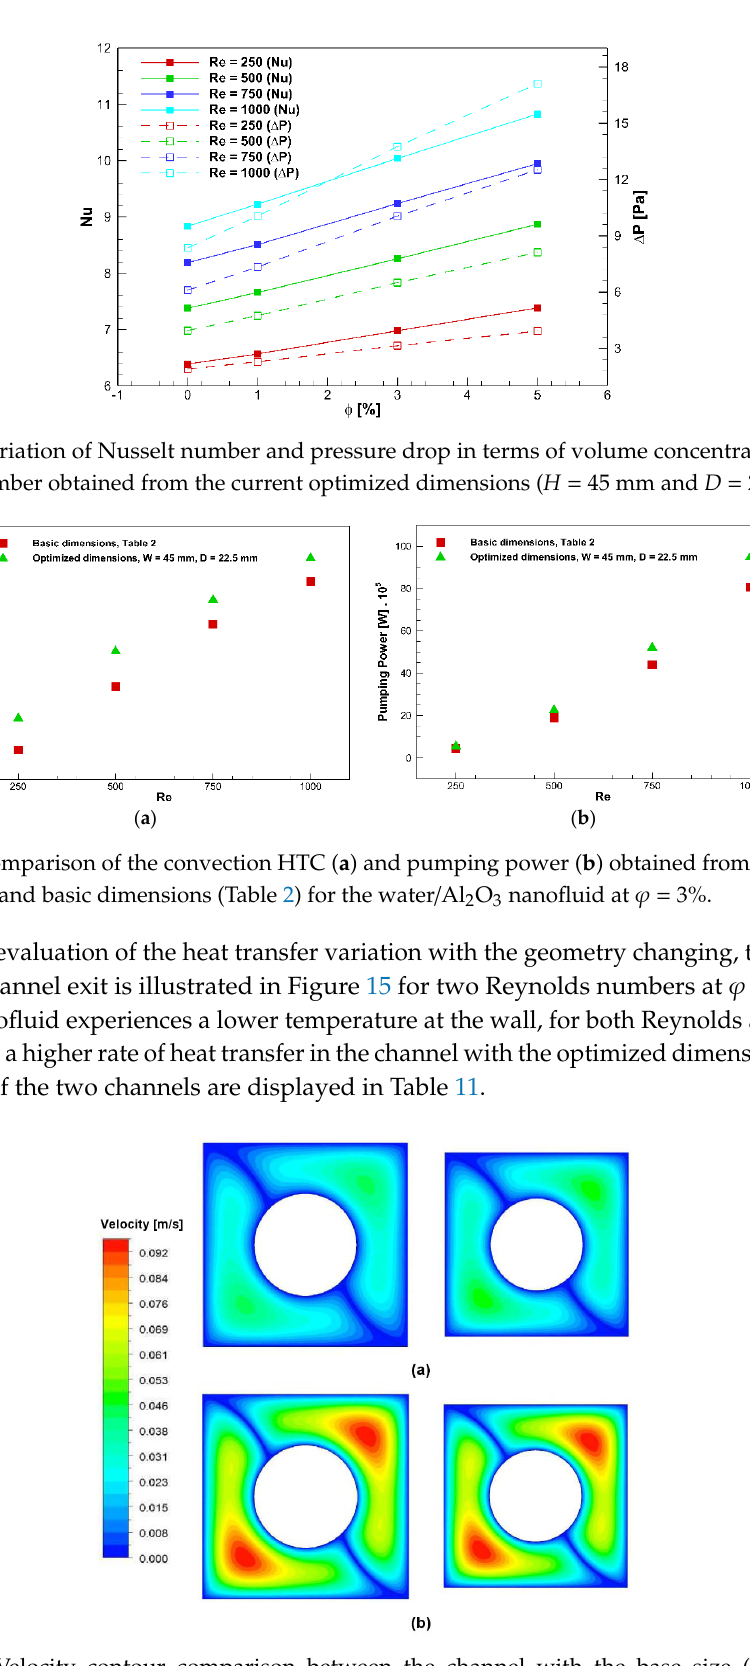
Figure 15. Velocity contour comparison between the channel with the base size (left Figure) and the optimum size (right Figure) at the channel exit at φ = 3% for: ( a ) Re = 500, and ( b ) Re = 1000. Table 11. The dimension of channels compared in Figure 15.